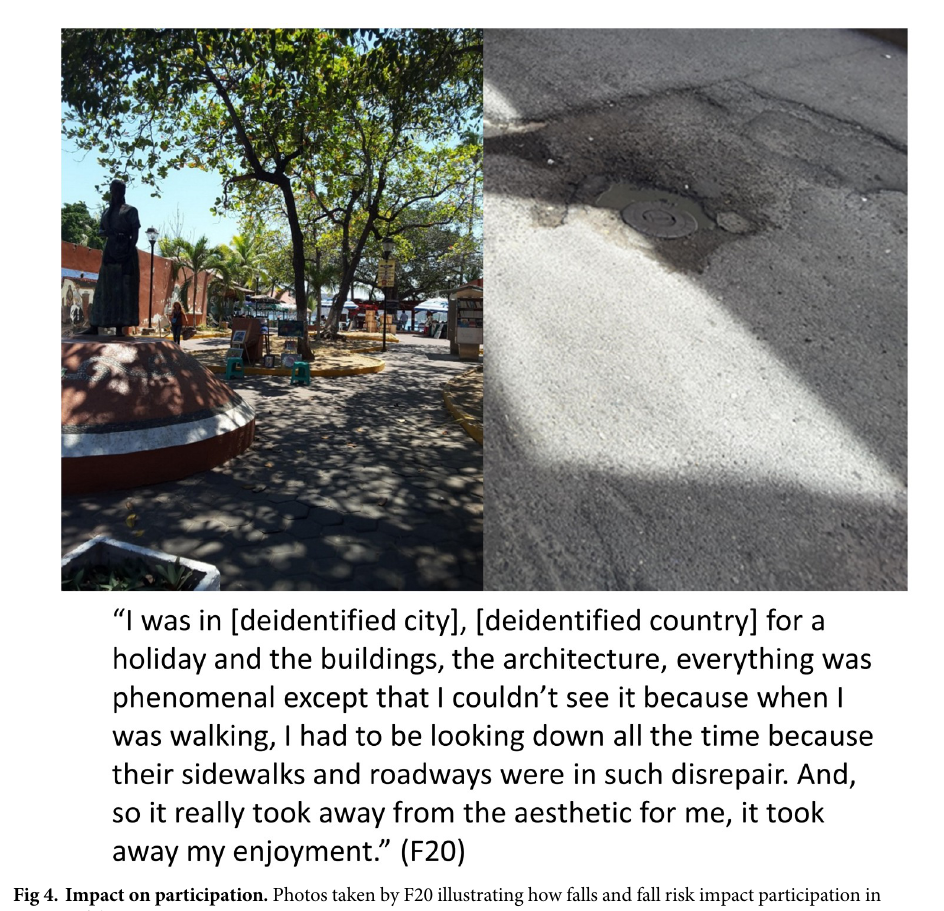
Fig 4. Impact on participation. Photos taken by F20 illustrating how falls and fall risk impact participation in meaningful activities.